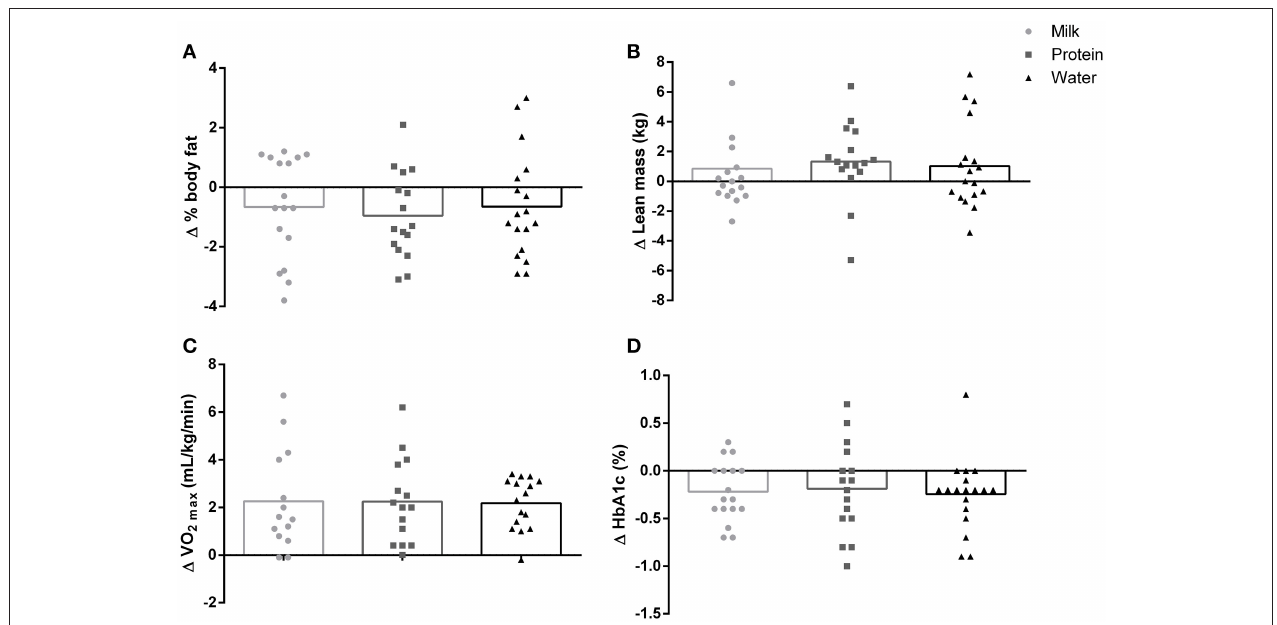
FIGURE 3 | Change from pre intervention for (A) % body fat, (B) lean body mass, (C) cardiorespiratory fitness ( ˙ VO 2peak ) and (D) glycosylated hemoglobin (HbA 1c ) in the milk, protein, and water groups (all main effect of time p < 0.05, no group interaction p > 0.05).